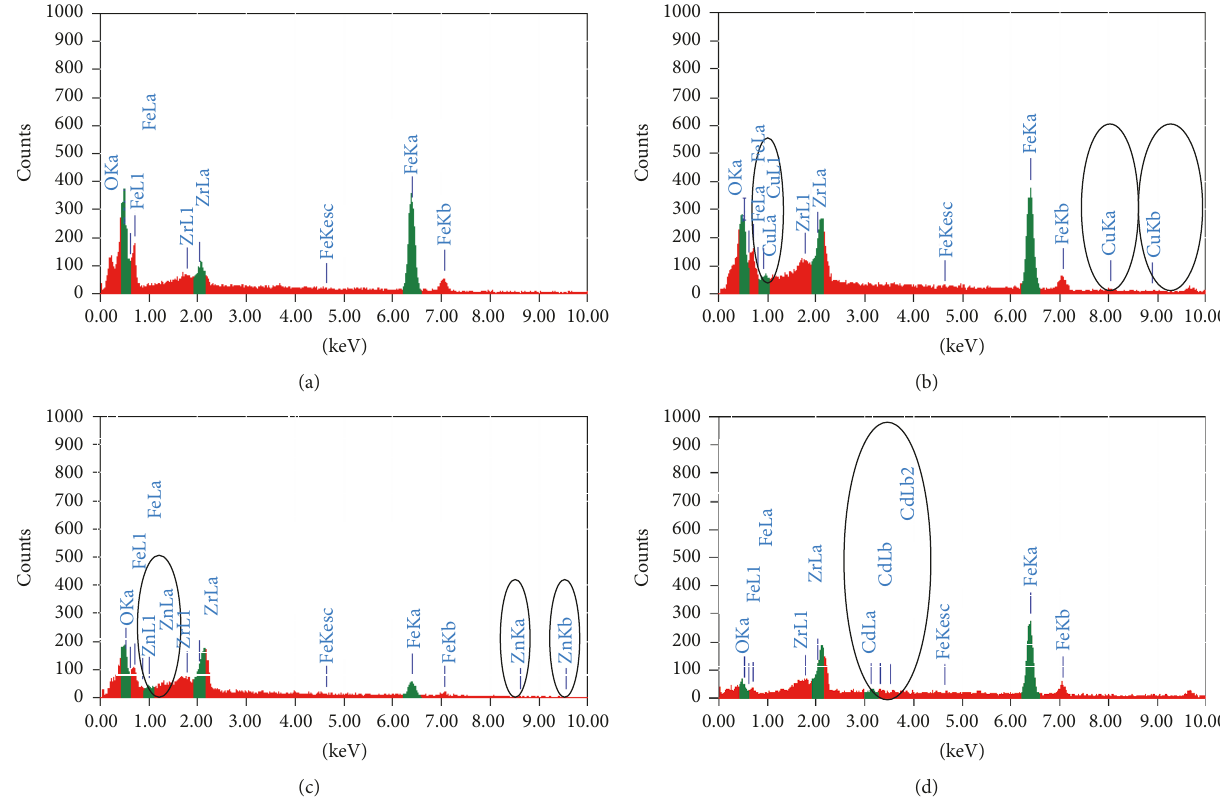
Figure 5: EDS spectra of the ferromagnetic sorbent (a) before and after adsorption of (b) Cu 2+ , (c) Zn 2+ , and (d) Cd 2+ [experimental conditions: sorbent dosage = 1g/L, initial concentration = 200 mg/L, and contact time = 24h].